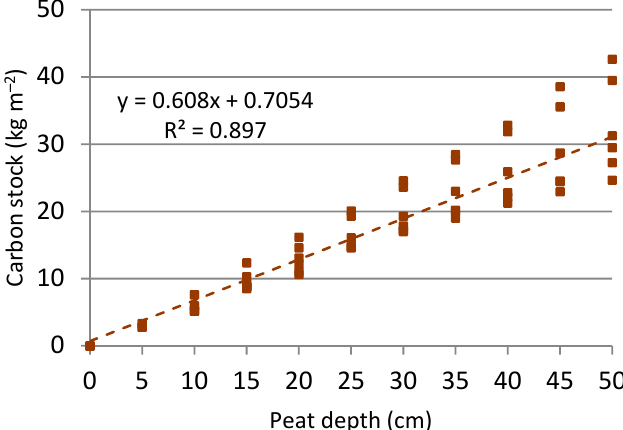
Figure 6. Soil carbon stock vs. peat layer thickness.